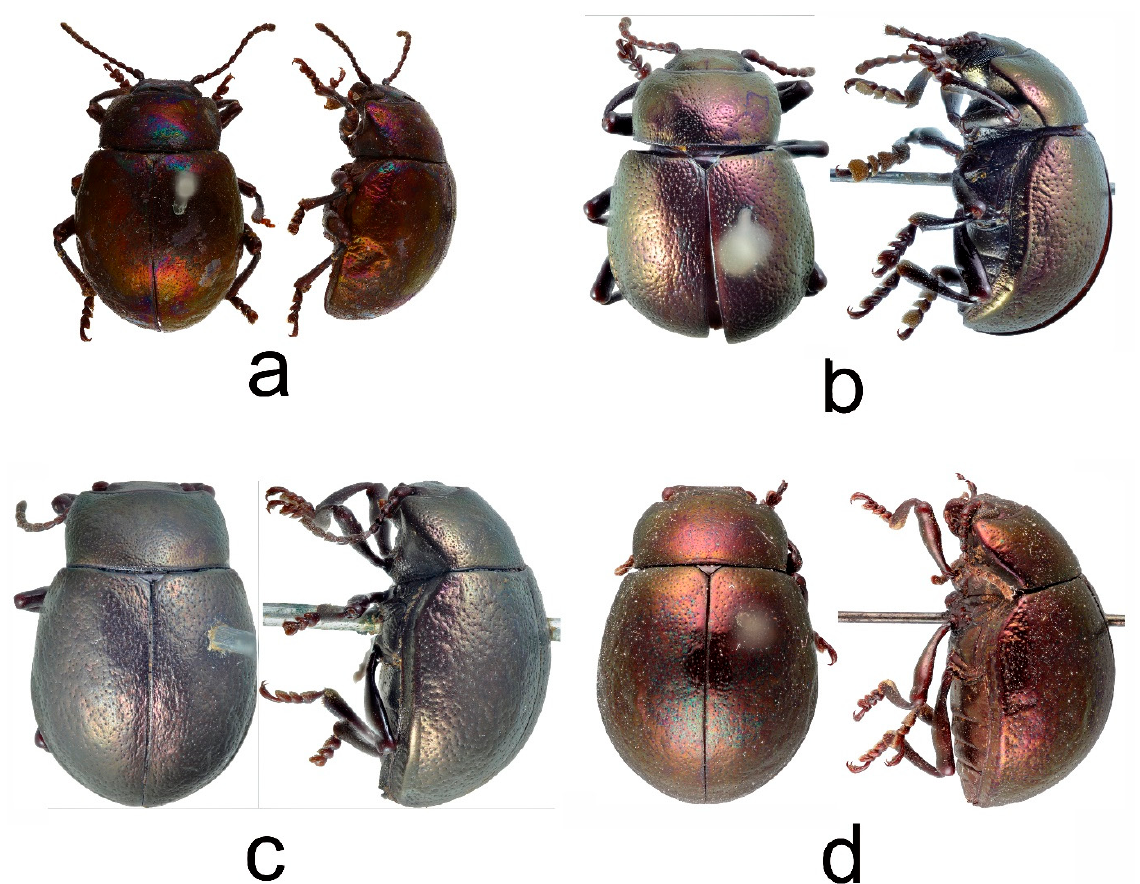
Figure 4. Type and historical specimens, dorsal and lateral view. ( a ) Timarcha hummelii , historical specimen, female, MNHN; ( b ) T. hummelii , neotype, male, ZMMU; ( c ) T. armeniaca , neotype, female, ZMMU; ( d ) T. hummelii starcki , syntype, male, NMB.